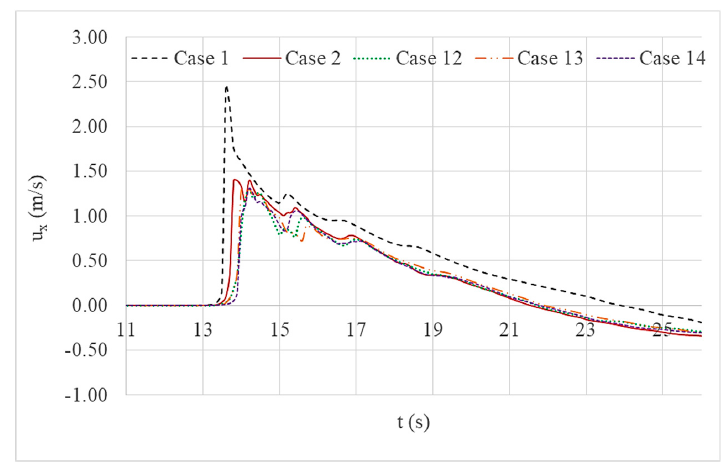
Figure 16. Comparison of current velocity (x-component) variations at location D.